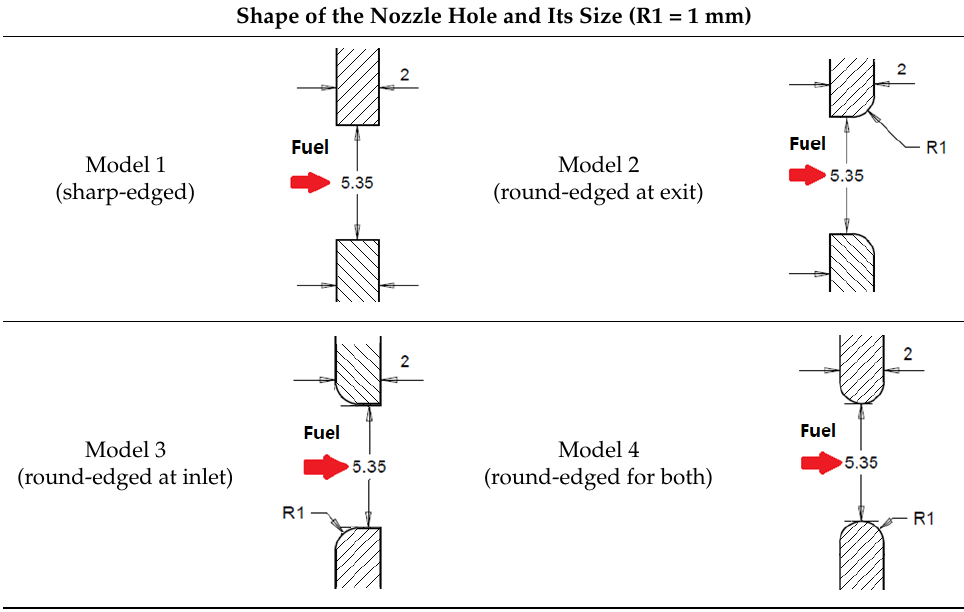
Table 3. Configuration of the different nozzle holes (unit: mm).